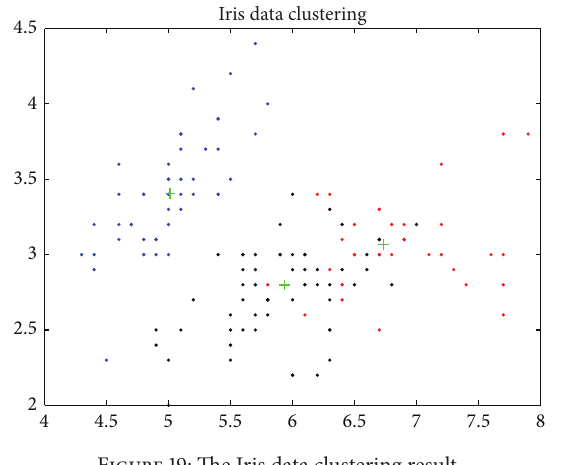
Figure 21: The survival data clustering